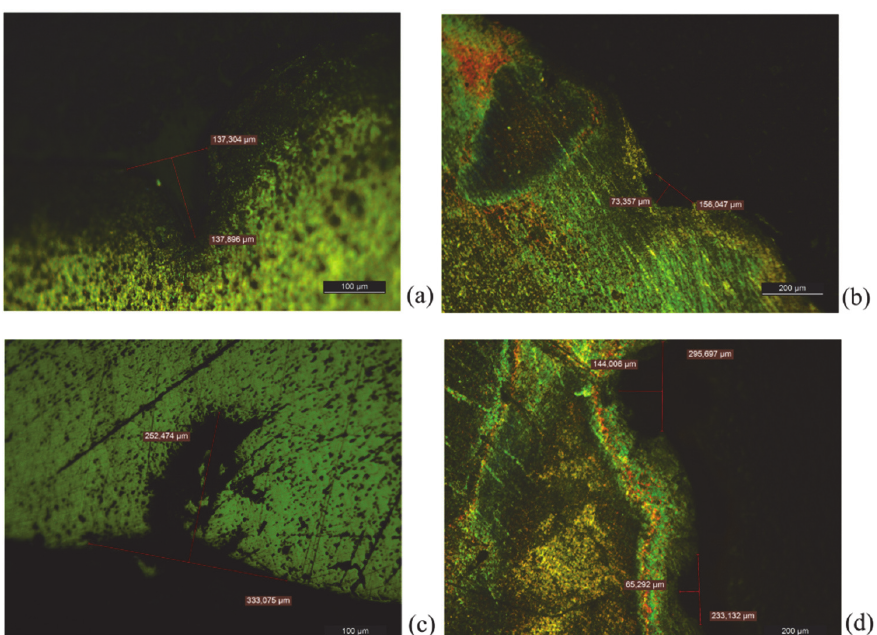
Figure 7: Corrosion damage: Depth of a pit after 30 days of corrosion of (a) non-blasted specimen and (b) of sandblasted specimen as well as pits after 60 days of corrosion of (c) non-blasted specimen and (d) sandblasted